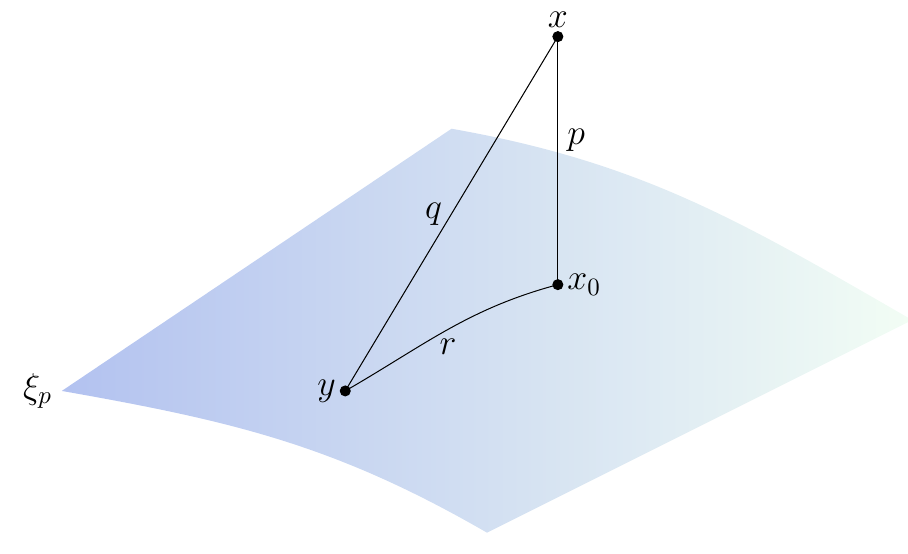
Figure 7 . Trigonometry for a triangle in a hyperbolic